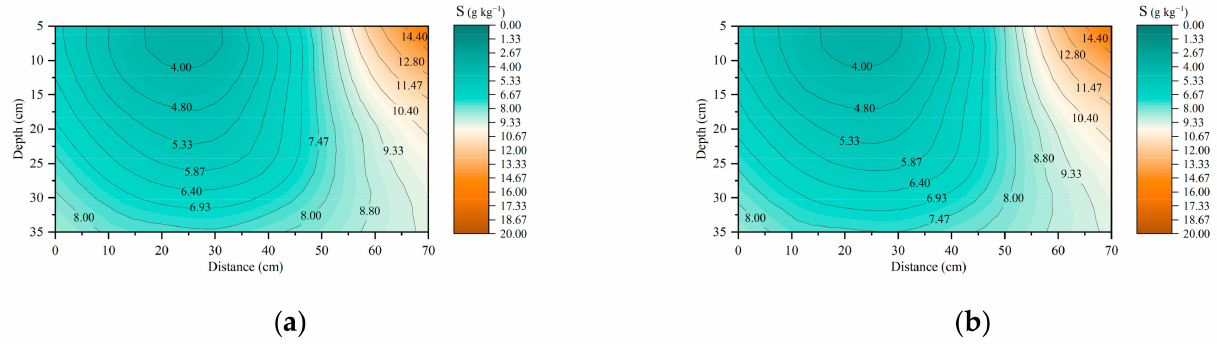
Figure 10. Simulated 2D distribution of soil salinity with instantaneous equilibrium adsorption at the end of experiment: ( a ) Simulated distribution under W1; ( b ) under